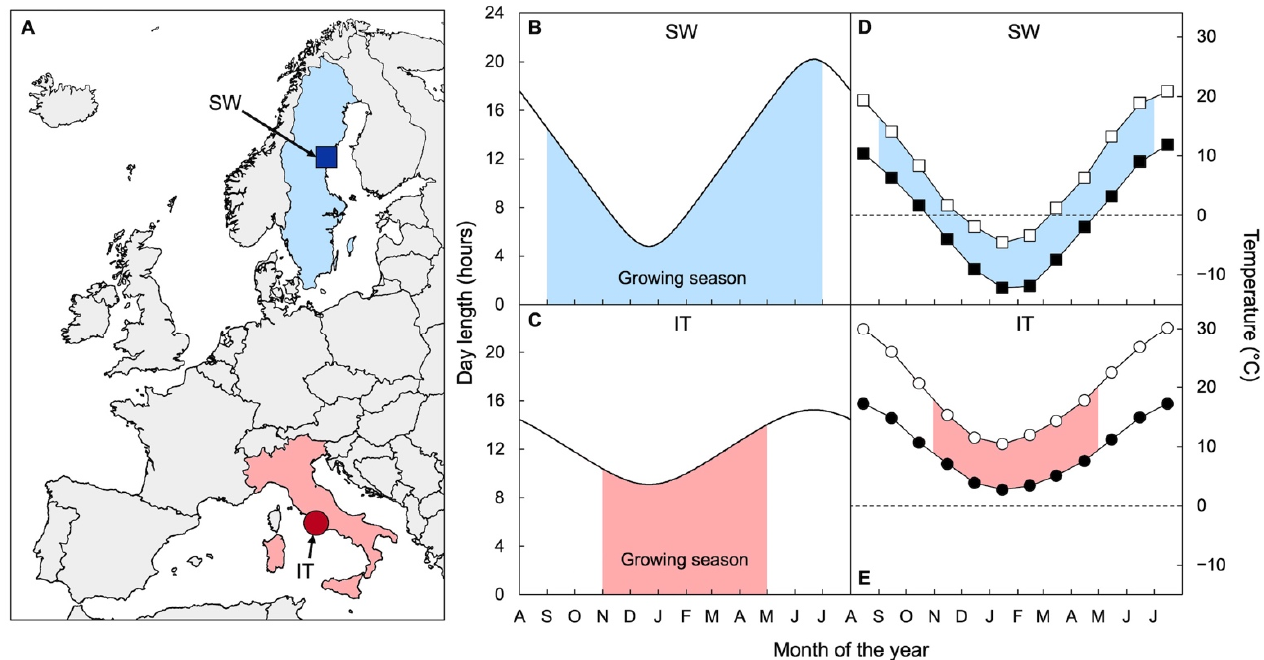
Figure 1. ( A ) Map showing the geographic origins of the SW (blue square; 62°48 ′ N, 18°12 ′ E) and IT (red circle; 42°07 ′ N, 12°29 ′ E) A. thaliana ecotypes (after [37]) as well as ( B , C ) the change in day length and ( D , E ) monthly minimal (closed symbols) and maximal (open symbols) temperatures across the growing season (light blue or red shading) for ( B , D ) SW and ( C , E ) IT at their respective sites of origin. Data on growing seasons for the two ecotypes from [41,46].